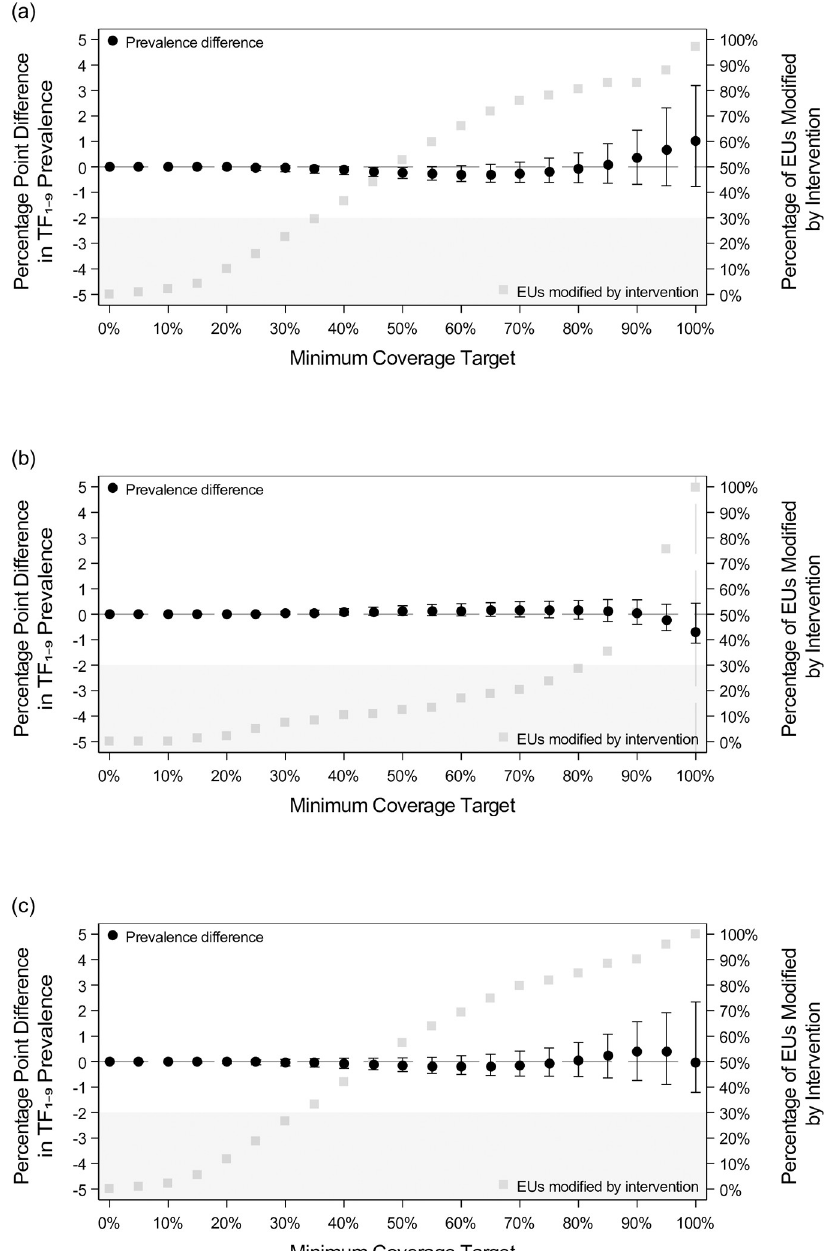
Fig 3. Prevalence difference and number and percentage of EUs modified after implementing hypothetical interventions on nearby face-washing water and latrine coverages among maintaining elimination target EUs. These figures show the results presented in Table 2 graphically for (a) nearby face-washing water interventions, (b) latrine interventions, and (c) simultaneous interventions on both nearby face-washing water and latrines for the maintaining elimination target EUs. When present, the vertical bar indicates the minimum coverage target at which the relative prevalence decrease was at least 25%. Shaded areas indicate values the prevalence difference cannot reach.